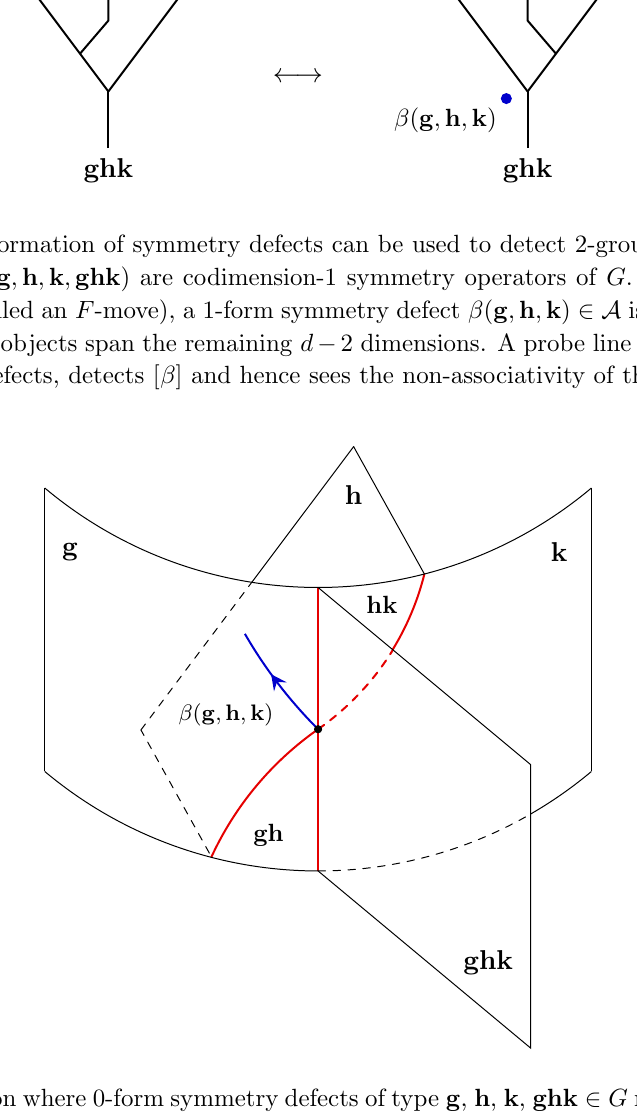
Figure 4 . A junction where 0-form symmetry defects of type g , h , k , ghk 2 G meet in codimension 3. This con(cid:12)guration is generic in spacetime dimension 3 and above. The junctions of three codimension-1 defects are in red, and their intersection is the black point. At the codimension-3 intersection, a 1-form symmetry defect (cid:12) ( g ; h ; k ) emanates, signaling the 2-group symmetry. In d dimensions, all objects span the remaining d (cid:0) 3